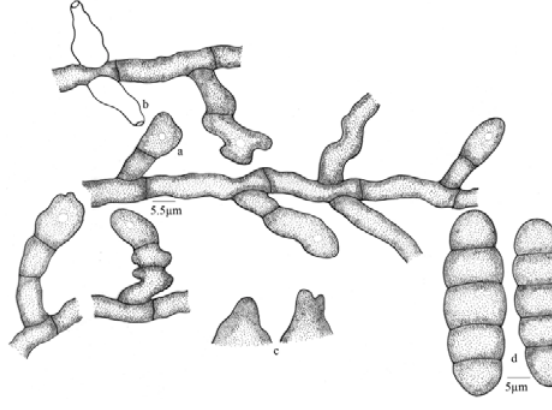
Figure 18. Asteridiella glycosmidis a - Appressorium; b - Phialide; d - Ascospores